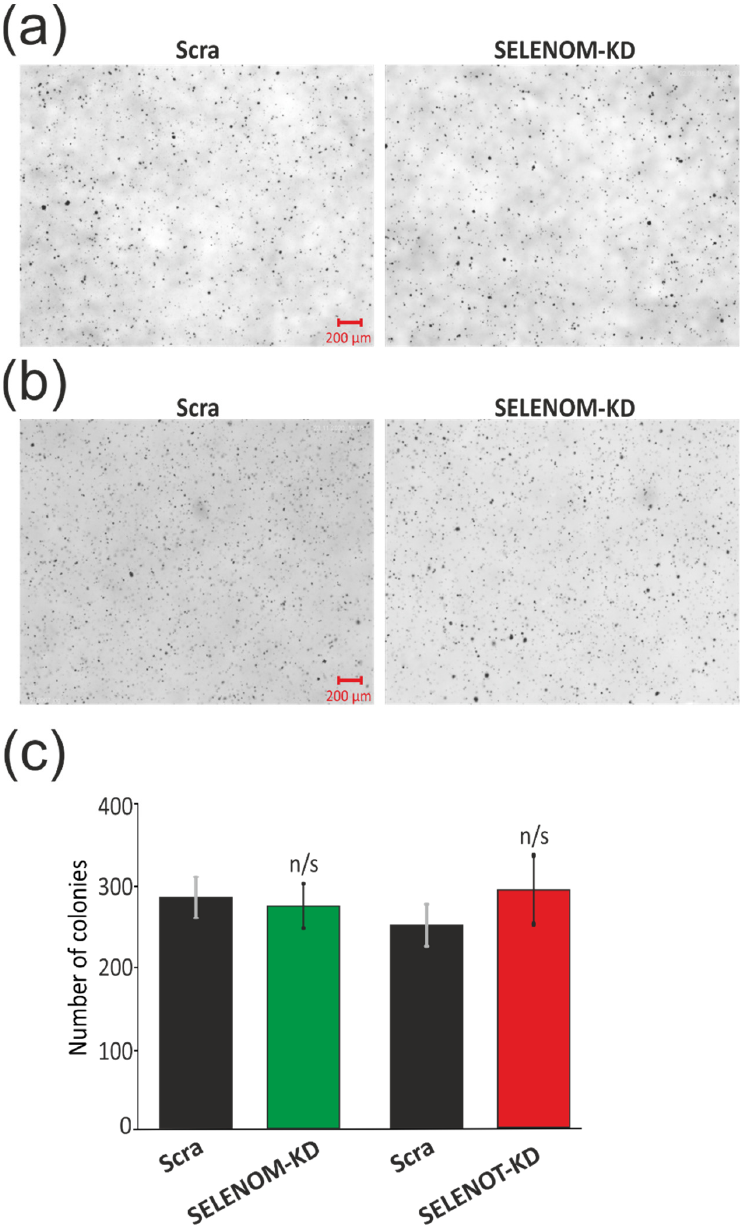
Figure 3. Effects of SELENOM-KD and SELENOT-KD on anchorage-independent colony formation in soft agar. Representative soft agar dishes with stained colonies for Control (Scra), SELENOM-KD ( a ), and SELENOT-KD ( b ). Quantification of grown colonies in A-172 cells with SELENOM-KD or SELENOT-KD and in control cells (Scra) ( c ). Three independent replications of this series of experiments were carried out. Comparison of KD groups vs. Scra: n/s—data not significant ( p > 0.05).